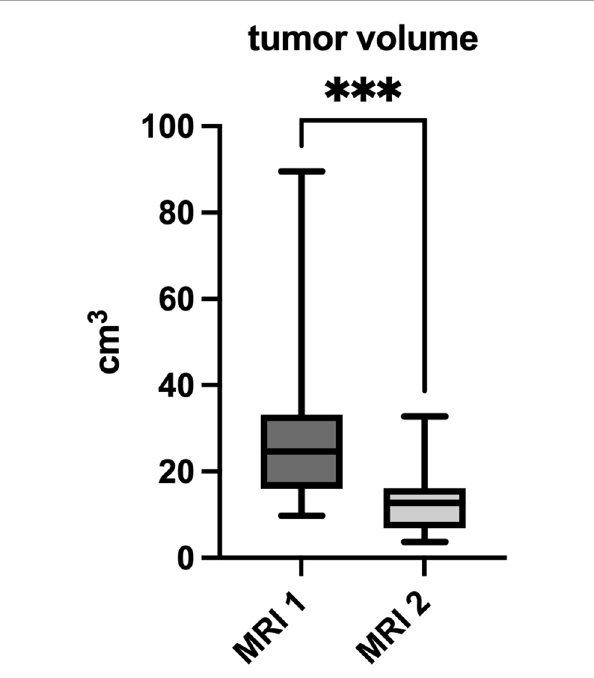
FIGURE 2 Tumor diameter in mm in staging MRI 1, MRI 2 and pathological examination. ** signi fi cance level α =0.01, *** α =0.001.